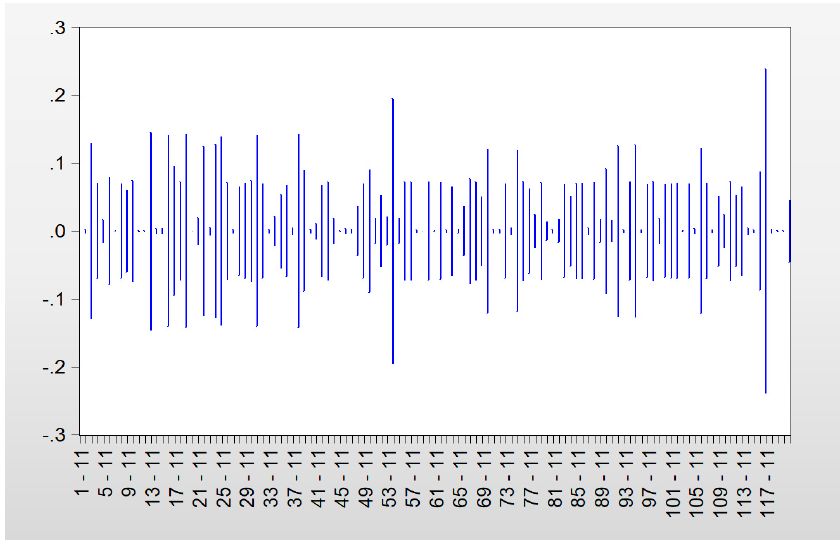
Figure 8. The influence of competitiveness and voting rights of major shareholders on the quality of CGSafter the COVID-19 pandemic. Source: Author’s computations.